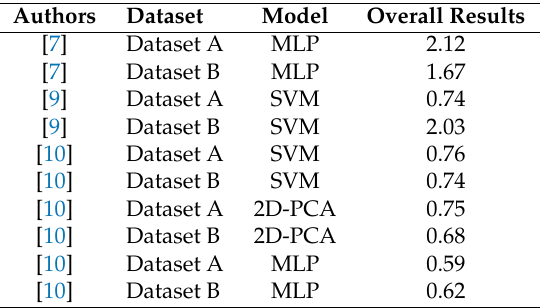
Table 1. Summary of Previous Work on Dataset A & Dataset